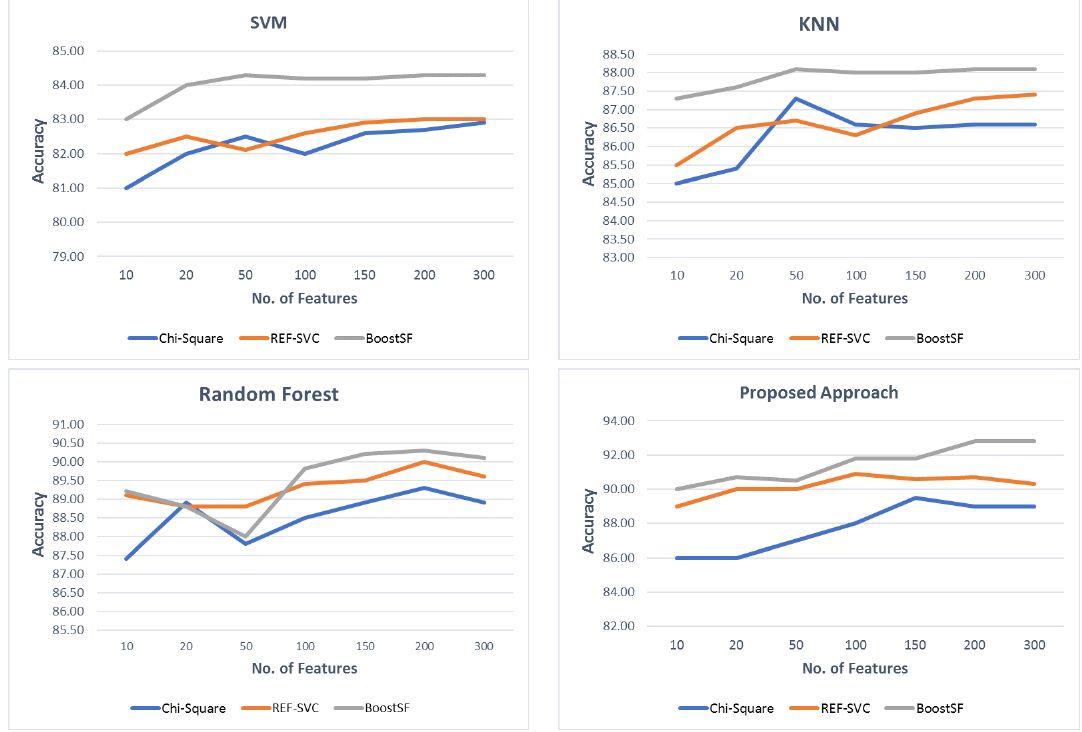
Figure 5. Comparison of the feature selection algorithms with different numbers of